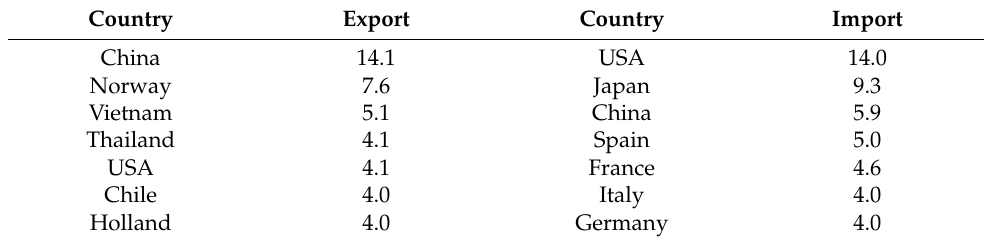
Table 3. Main exporting and importing nations of aquaculture products in 2020.